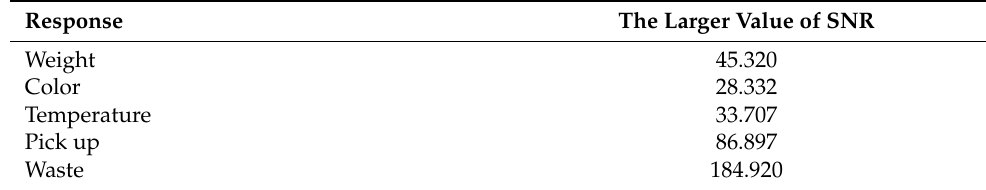
Table 6. The largest value of SNR is chosen, which is a better performance response for each